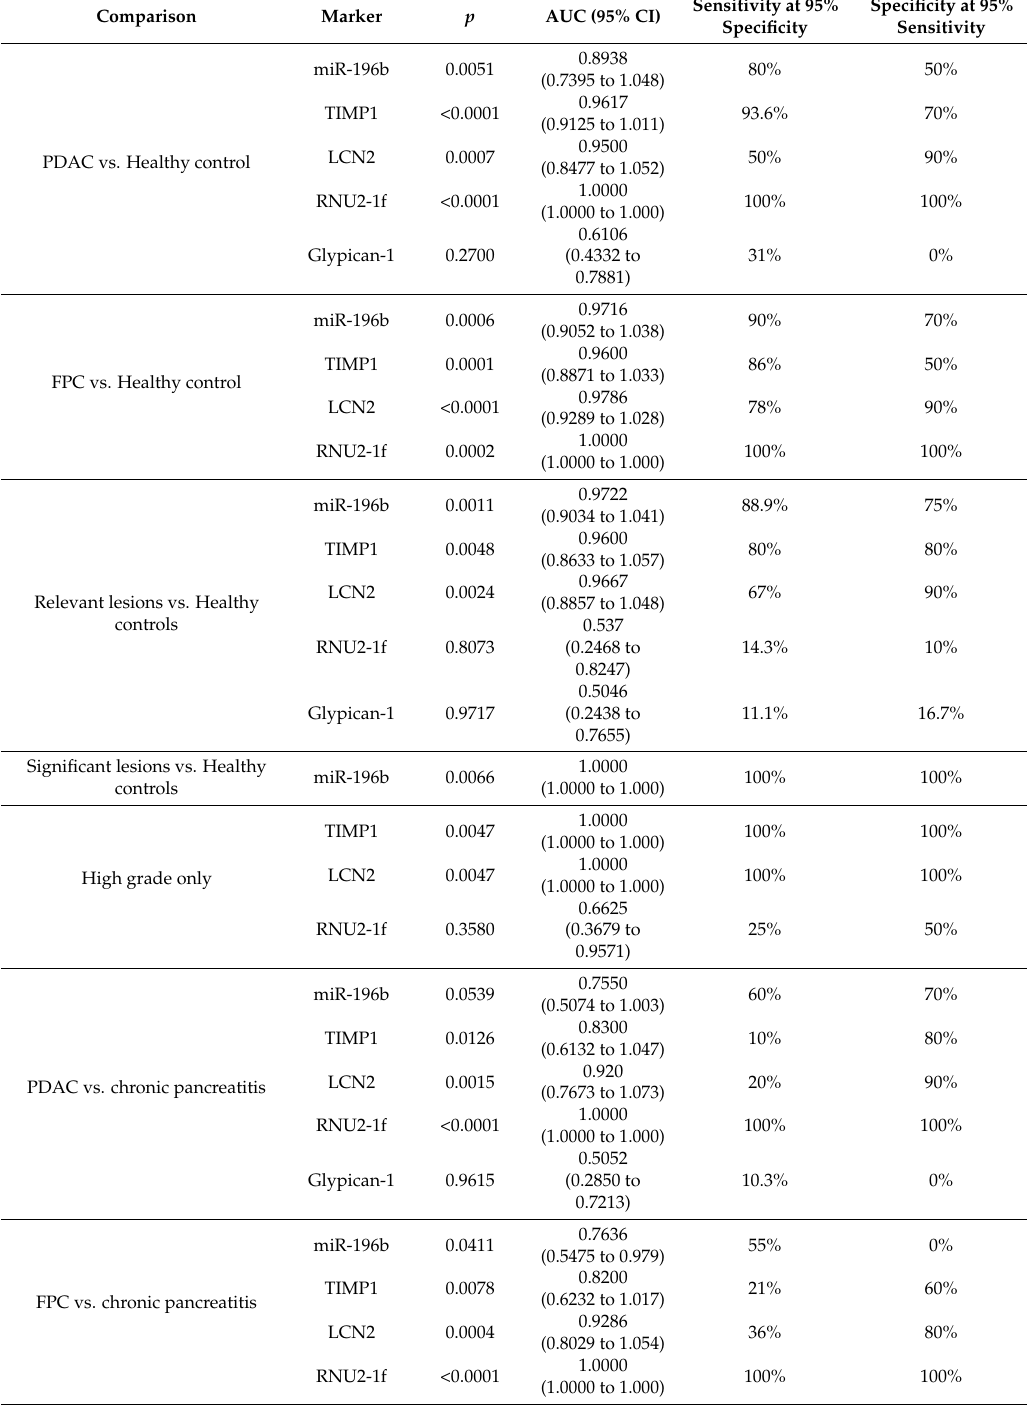
Table 3. Performance of serum biomarkers in a combined validation